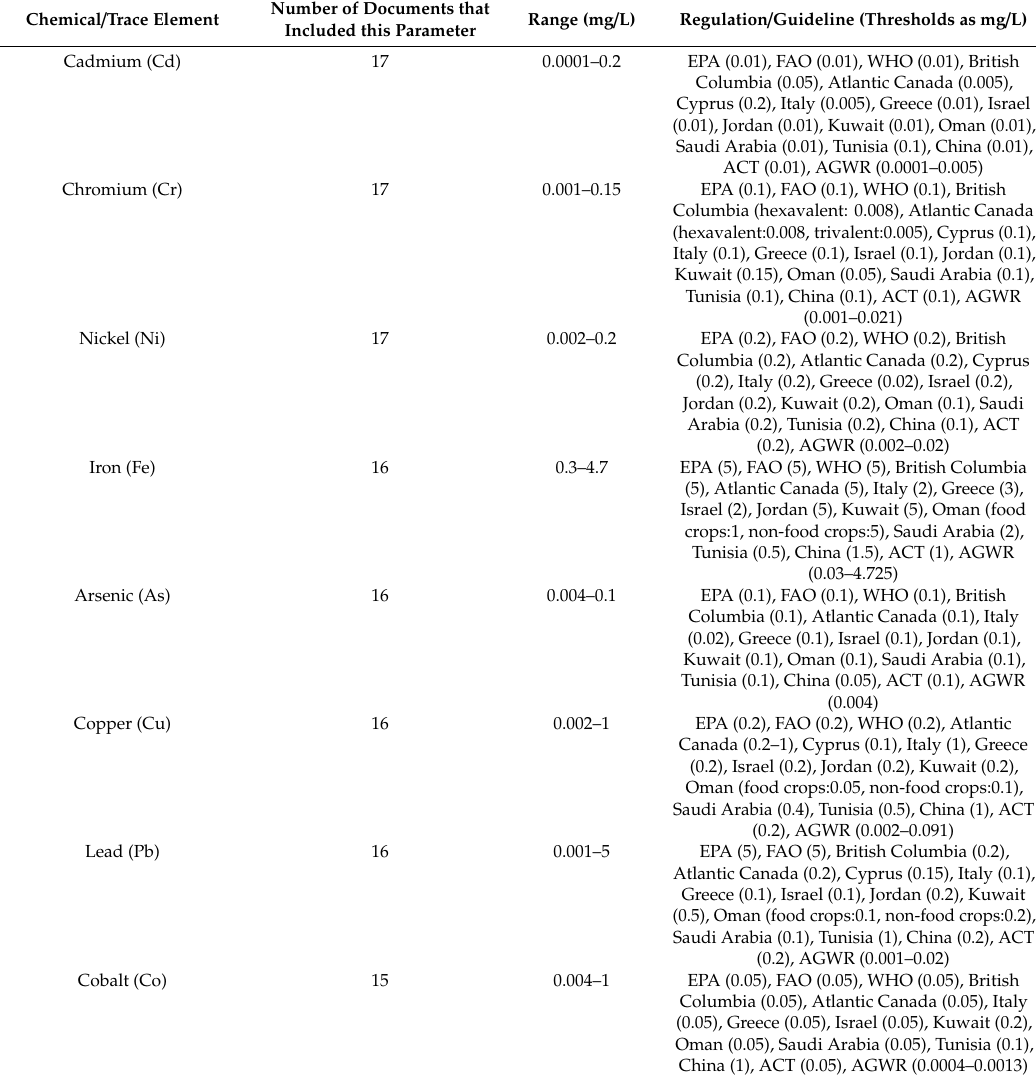
Table 7. Chemicals and trace elements thresholds in agricultural water reuse regulations and guidelines (numbers in parentheses show the threshold level of chemical constituents and trace